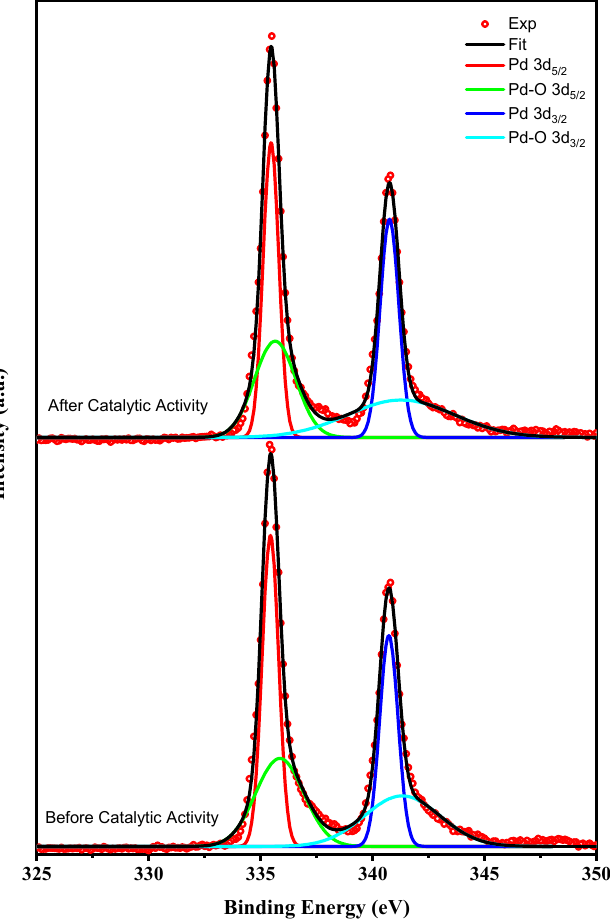
Figure 3. High-resolution XPS spectra of Pd 3d core level.